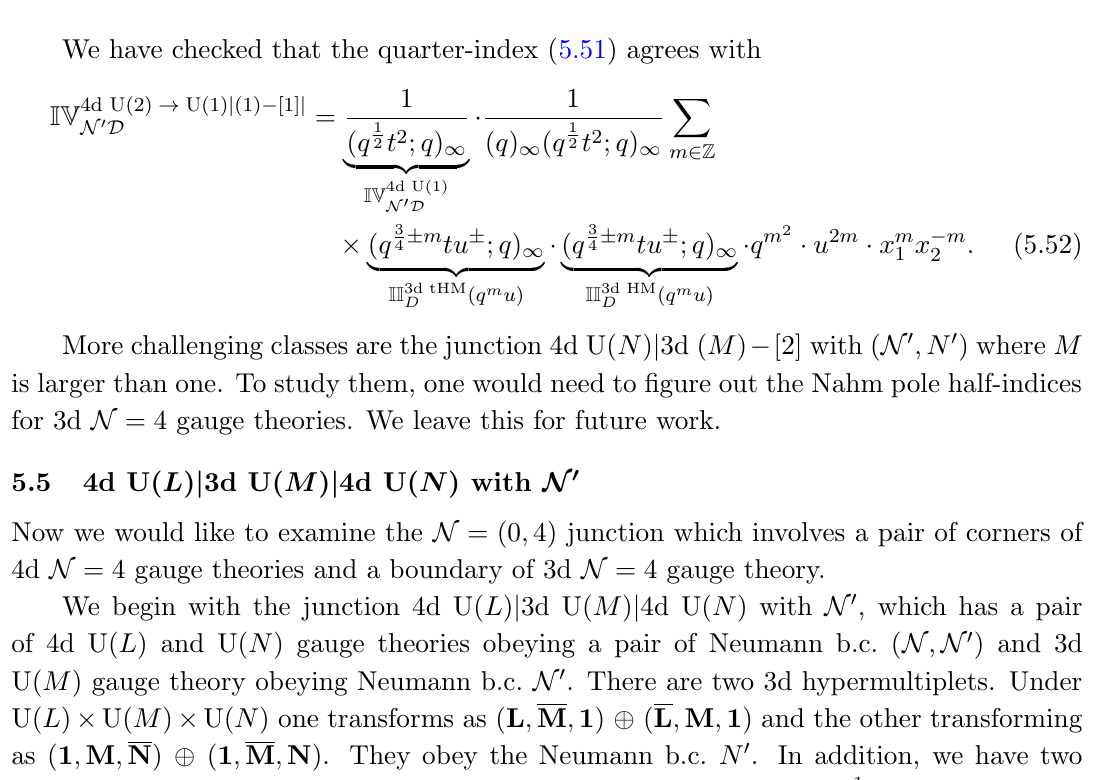
Figure 15 . The brane constructions of the configuration 4d U( L ) and its mirror corner configuration that has no gauge b.c. N (cid:31)